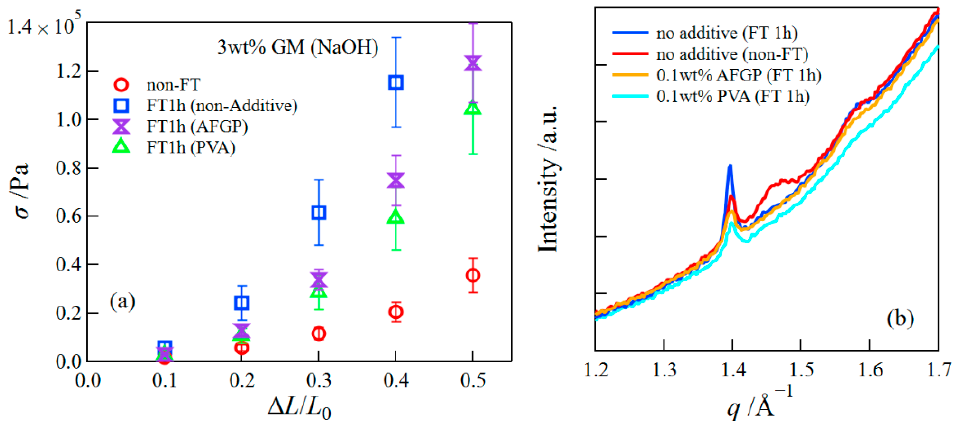
Figure 8. The compressive stress at different strains ( a ) and WAXS curves ( b ) for the freeze-thawed GM/AFGP and GM/PVA gels.